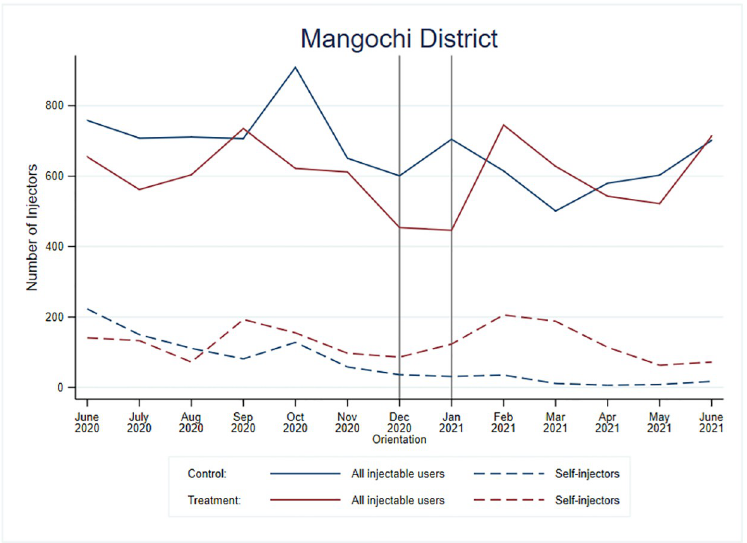
Fig 3. Number of total new injectable users and DMPA-SC self-injectors for treatment and control facilities in Mangochi District, Malawi.